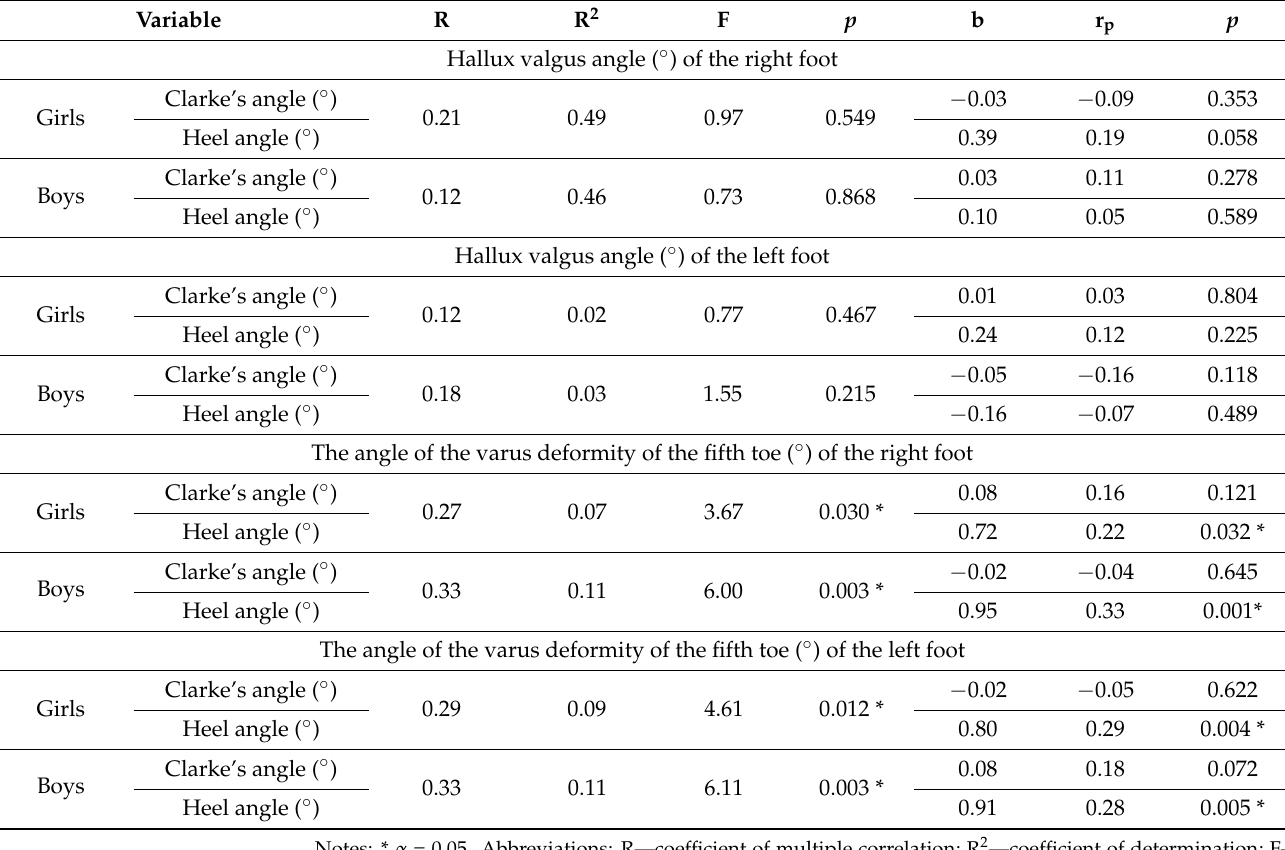
Table 6. Regression models in which the independent variables are the indices of longitudinal and transverse arching of the